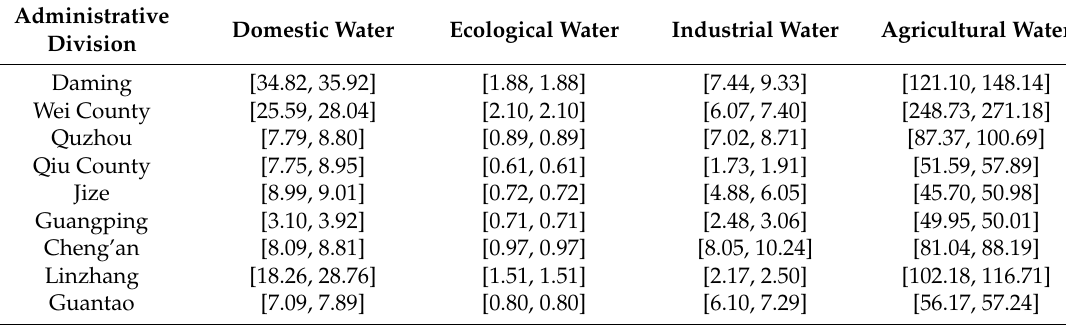
Table 10. Result of groundwater allocated to every user (w i = (0.2, 0.1, 0.7)) (10 6 m 3 ).